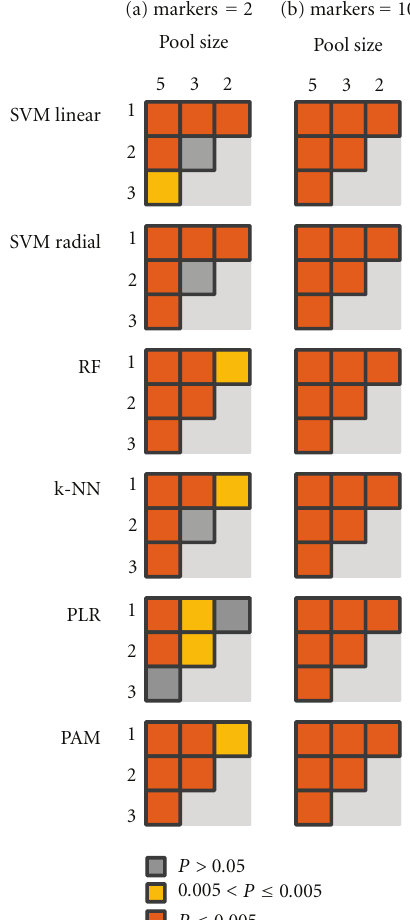
Figure 2: Statistically significant matrices of classifiers performances among various pool sizes datasets. Statistically significant di ff erences of performances of classifiers among di ff erent pool sizes of 1 (individual), 2, 3, and 5 are shown using Wilcoxon rank sum test, respectively. (a) and (b) show the matrices when numbers of synthesized markers are 2 and 10, respectively. Each square represents a comparison between two pool sizes datasets. The colors indicate the level of